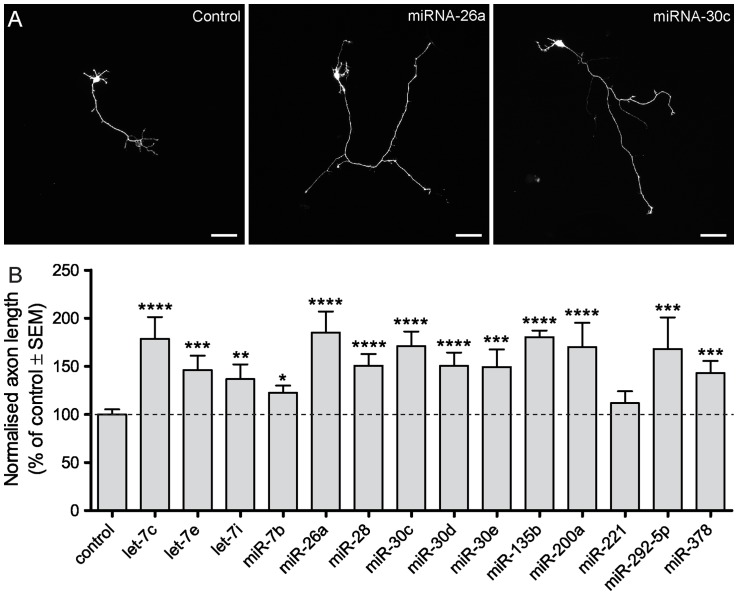
Sustained expression of subset of miRNAs modulates axonal outgrowth.A) Hippocampal dissociated neurons were co-transfected with GFP vector and miRIDIAN mimics for let-7c, let-7e, let-7i, miR-7b, miR-26a, miR-28, miR-30c, miR-30d, miR-30e, miR-135b, miR-200a, miR-221, miR-292-5p, miR-378 and miRNA. Three representative images of miRNA mimic transfected hippocampal neurons are shown. Scale bar, 50 μm. B) Graph represents measurement of total axon length. The average axon length of miRNA mimic expressing neurons is longer compared to control neurons (175.5 ± 10.2 μm). * p<0.01, ** p<0.001, *** p<0.0001, **** p<0.00001 in one way ANOVA with bonferroni correction for multiple testing.